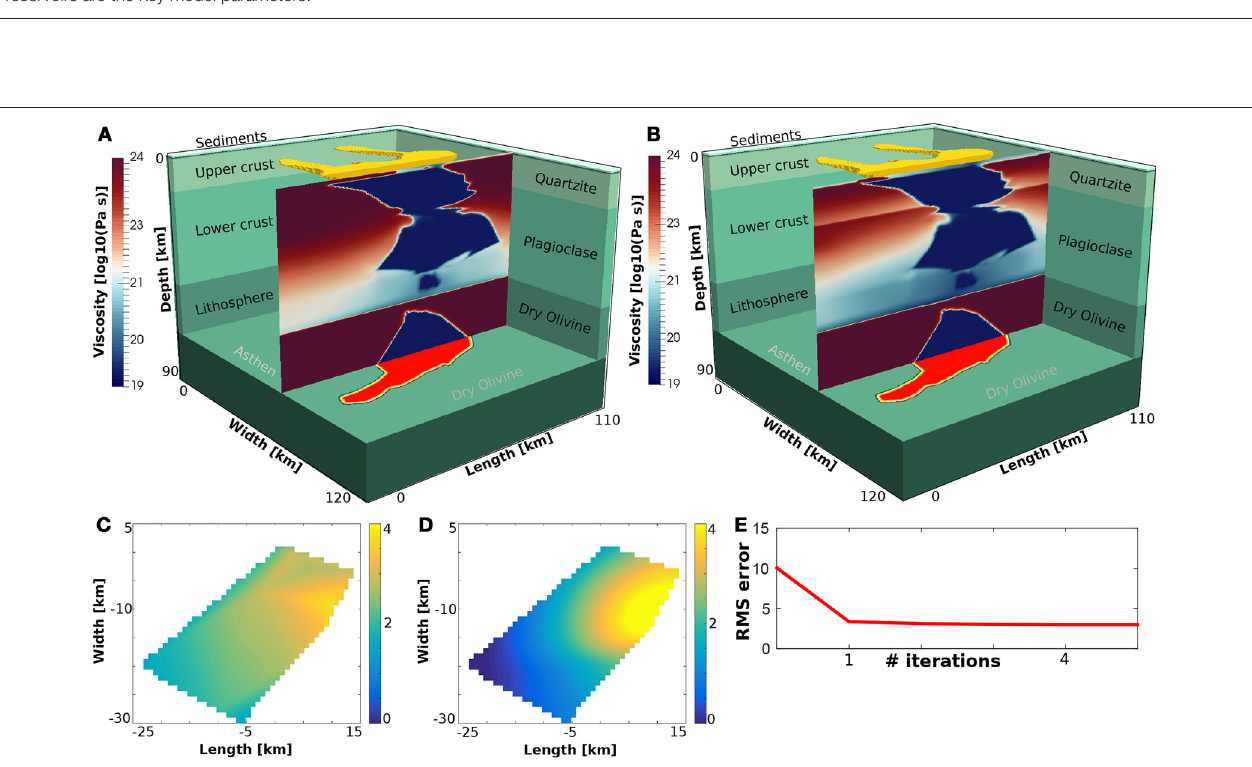
FIGURE 8 | Summary of the adjoint inversions for material parameters. (A) Initial viscosity field of the visco-elasto-plastic connected case was ( Figure 5C ) used as starting guess for the inversion. (B) Final viscosity field after converged iterations, showing a significantly weakened crust by increasing the powerlaw exponents of the crust. (C) Map view of interpolated surface uplift from Chang et al. (2010) during the period of September 2007–September 2008, which is used as data for our inversions. (D) Map view of the vertical surface velocity field after converged iterations. Both the patterns and magnitude are similar, even though the numerical model has lower velocities toward the boundaries of the map, perhaps caused by crustal heterogeneities that were not taken into account in the models. (E) Cost function as root mean square of vertical surface velocity vs. number of iterations. Due to a good initial guess and robust line search acceleration, convergence is achieved quickly.